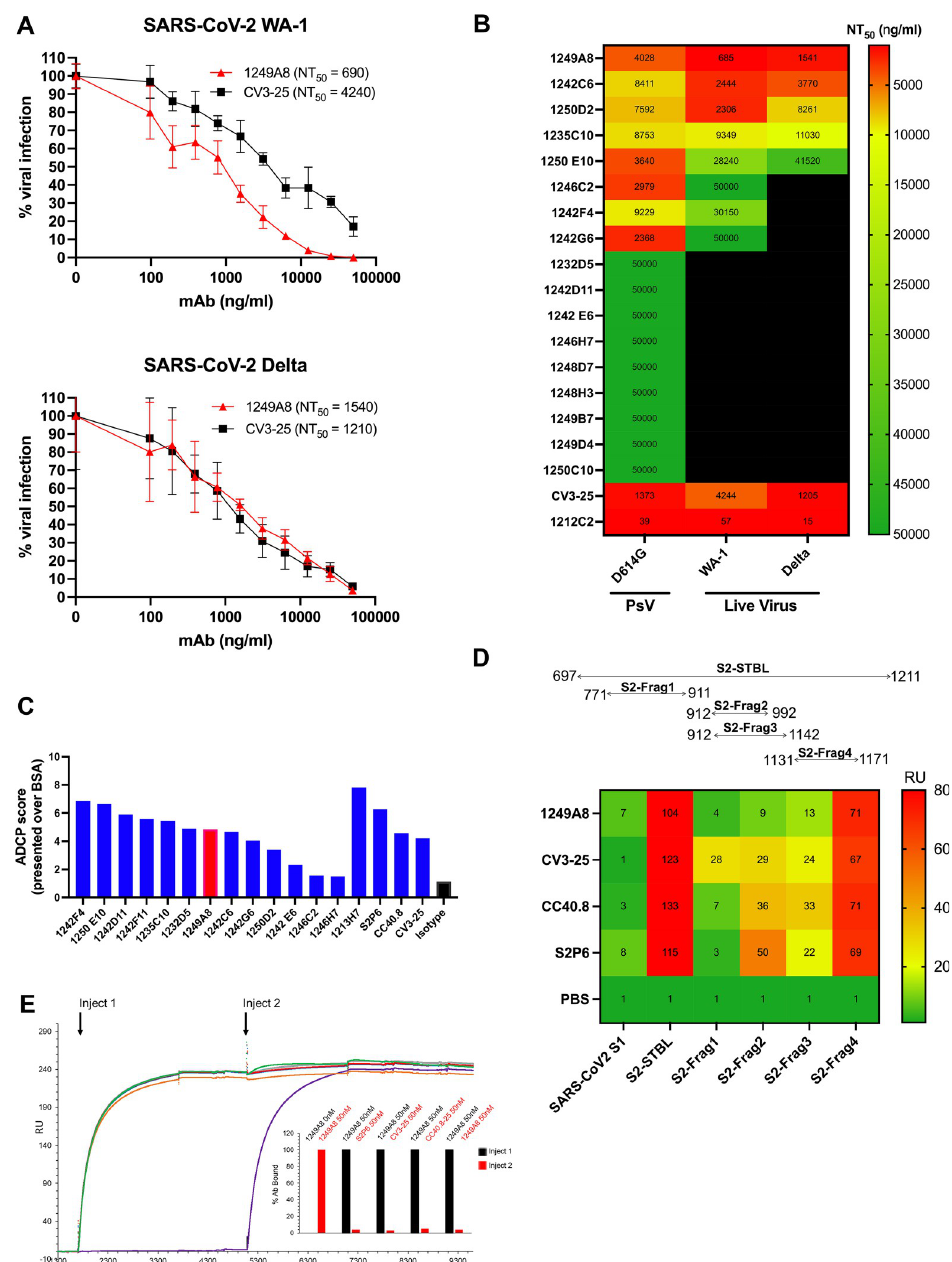
Fig 2. In vitro neutralization and ADCP of SARS-CoV-2 by S2- specific hmAbs. ( A ) SARS-CoV-2 neutralization of S2 hmAbs. Vero E6 cells were infected with SARS-CoV-2 WA-1 or SARS-CoV-2 Delta for 1 h. After 1 h of viral adsorption, the indicated concentrations of S2 hmAbs were added and at 24 h.p.i., infected cells were fixed for virus titration by immunostaining assay. Data was expressed as mean and SD of quadruplicates. ( B ) Summary of viral neutralization (NT 50 ) using either pseudovirus representing SARS-CoV-2 D614G mutation, or live SARS-CoV-2 WA- 1 or Delta. ( C ) Ab-dependent cellular phagocytosis (ADCP) assay. SARS-CoV-2 Wuhan-Hu-1 S-coated and BSA- coated beads were incubated with 5 μ g/ml hmAb for 2 h and then added to THP-1 cells. After incubation for 3 h at 37˚C, cells were assayed for fluorescent bead uptake by flow cytometry. The ADCP score of each mAb was calculated by multiplying the percentage of bead positive cells (frequency of phagocytosis) by the mean fluorescence intensity (MFI) of the beads (degree of phagocytosis) and dividing by 10 6 . ( D ) Binding to S2 protein fragments by hmAbs (5 μ g/ ml) determined by ELISA. ( E ). SPR competition assays were performed by capturing S2-Frag4 to the chip surface, followed by sequential injections of 50 nM of 1249A8 (Inject1) and the various S2 Abs at 50nM concentration (Inject 2). (Inset) Summary of the competition sensorgram data, where Ab binding levels (RU), measured after Inject1